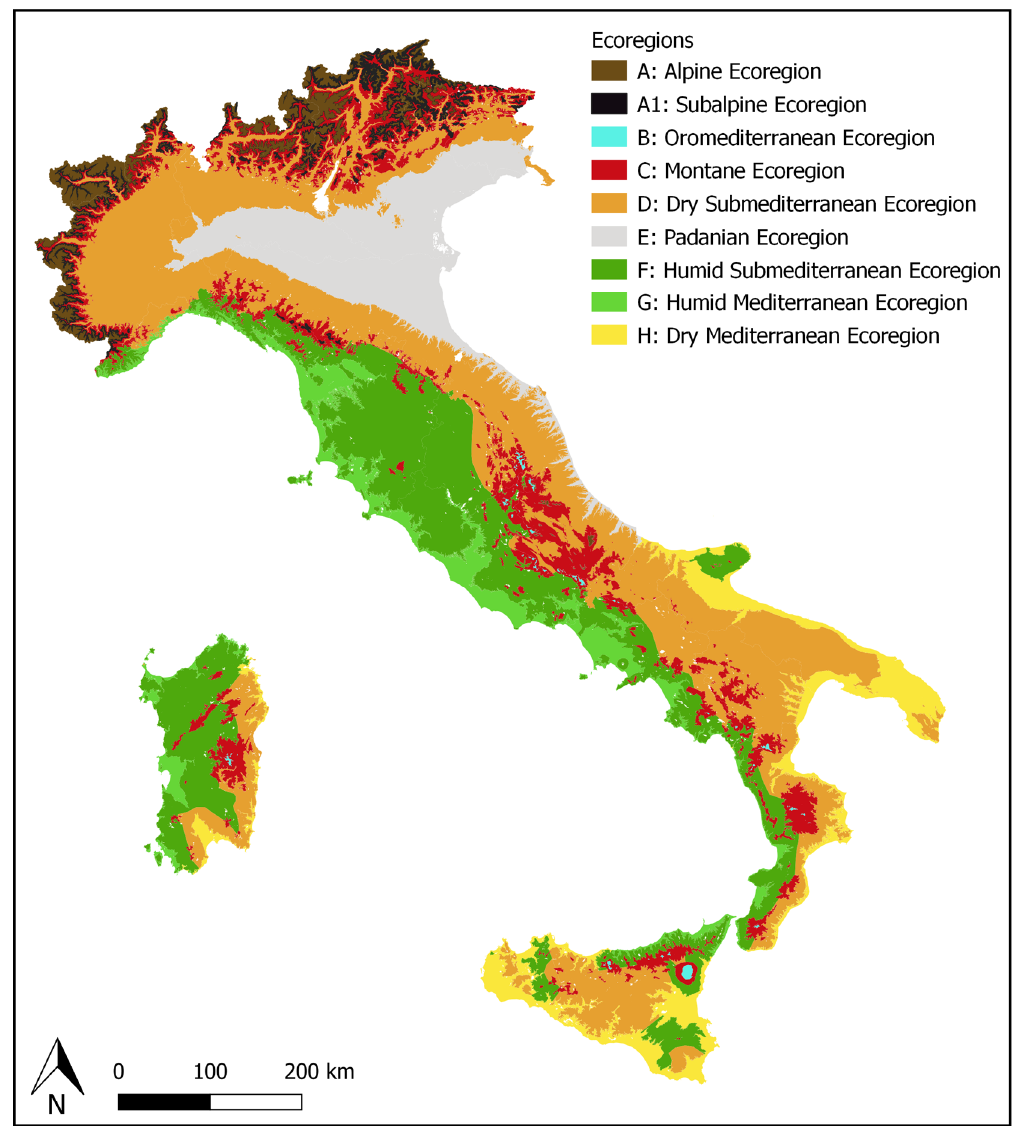
Figure 1. The 9 ecoregions adopted in ITALIC: Alpine (A), Subalpine (A1), Oromediterranean (B), Montane (C), Dry Submediterranean (D), Padanian (E), Humid Submediterranean (F), Humid Mediterranean (G), Dry Mediterranean (H). Table 1. Altitudinal range for each of the 97 OGUs. For each OGU, its name in the database, the ecoregion to which it belongs (see Figure 1, and the text for details), and the elevation range are provided. OGU Administrative Region Ecoregion Altitudinal Range